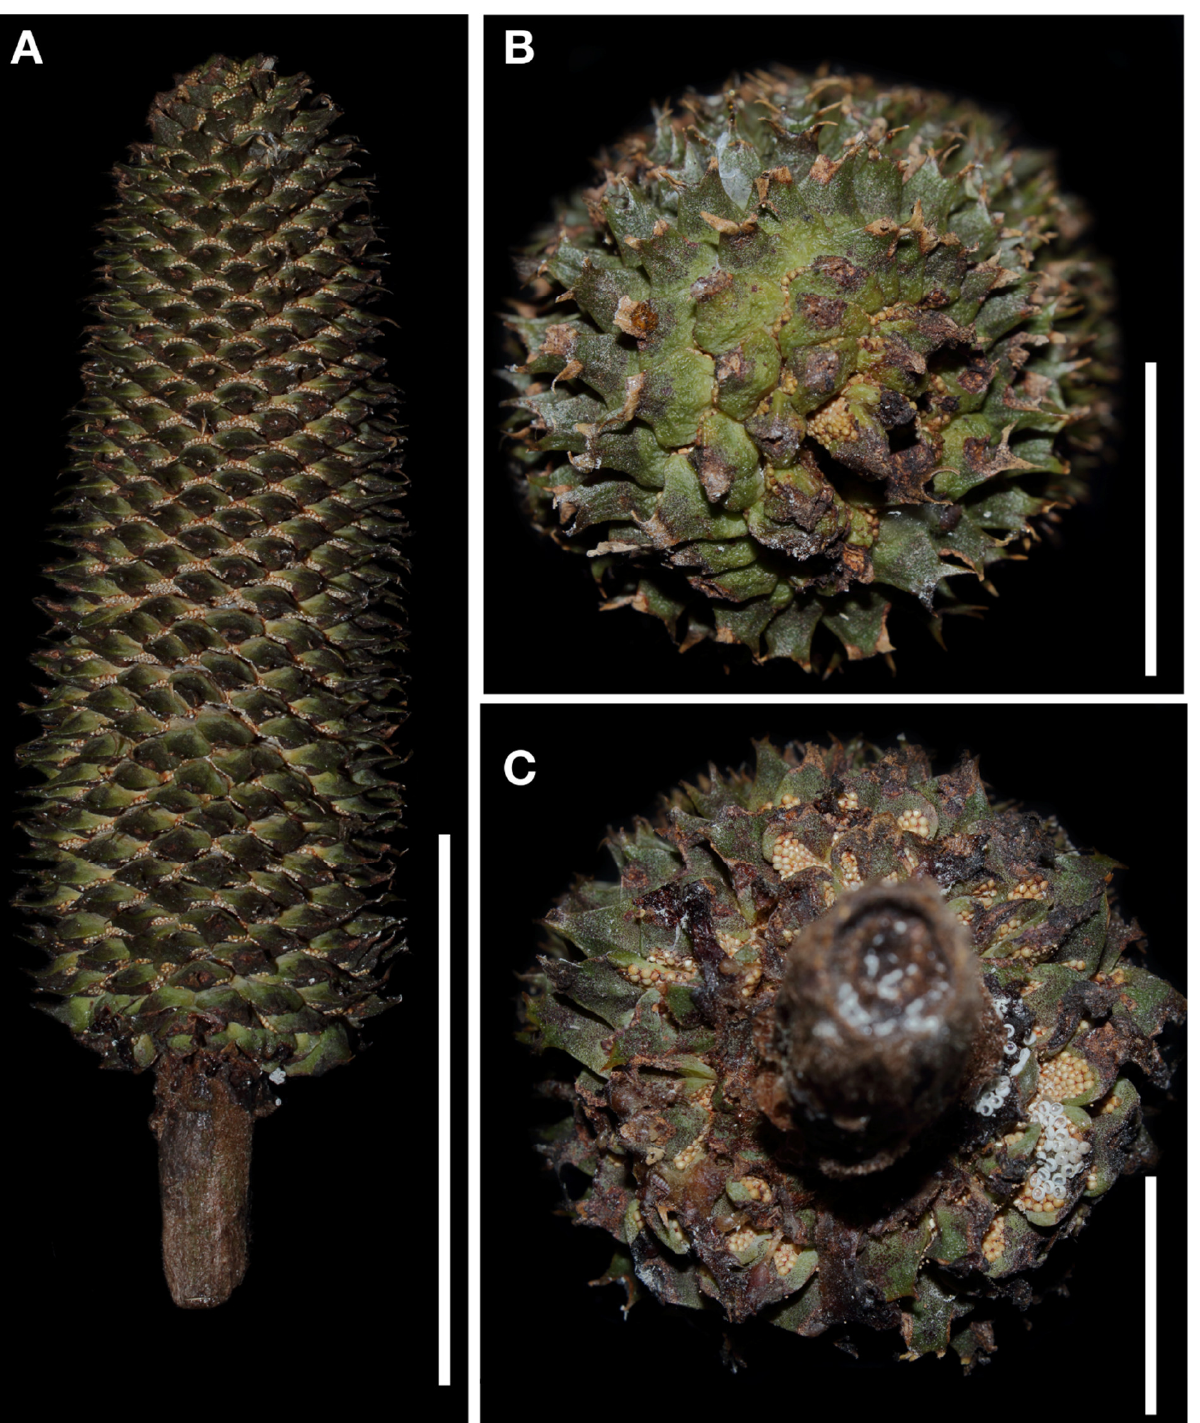
Figure 7. Microstrobilus of Ceratozamia schiblii at near pollen dehiscence phase. ( A ) Lateral view (scale = 10 cm); ( B ) view from above (scale = 2 cm), ( C ) view from below (scale = 2 cm). Photos by José García González.